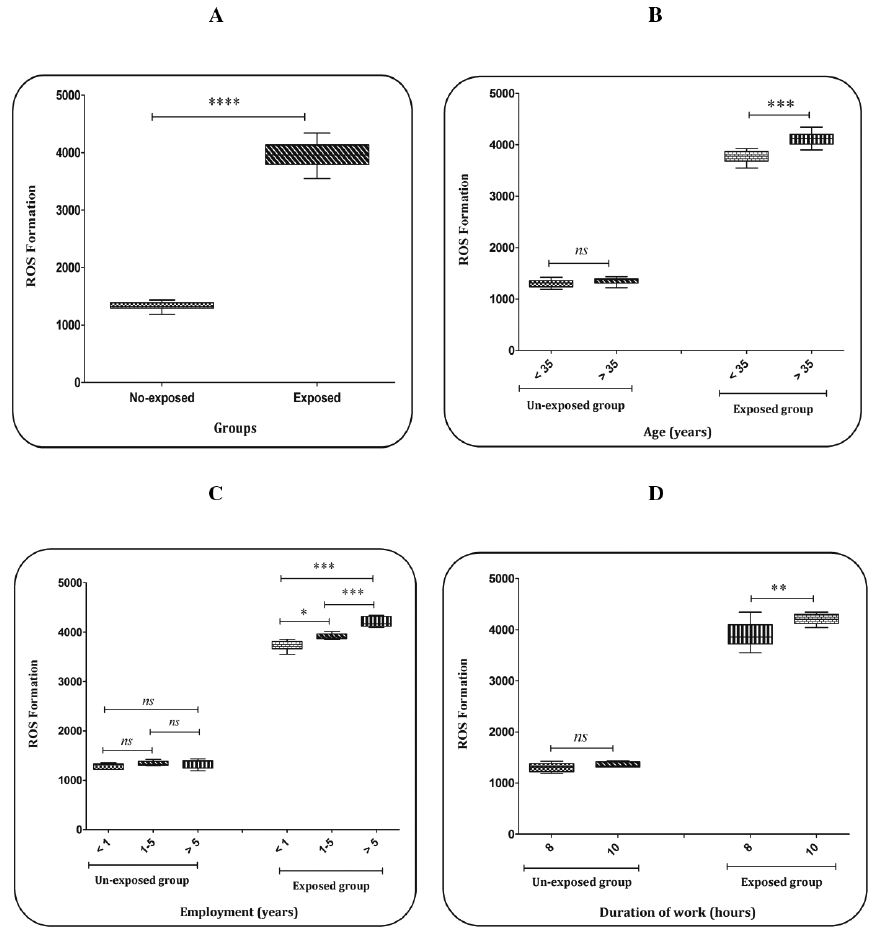
Figure 2: The mitochondrial ROS assay. (a) Comparison between exposure and non-exposure groups. (b) Comparison between the exposed and unexposed groups based on age (year). (c) Comparison between the exposed and unexposed groups based on employment (year). (d) Comparison between the exposed and unexposed groups based on duration of work (hours). Data are presented as mean ± SD (n = 20). * P < 0.05, ** P < 0.01, *** P < 0.001 and **** P < 0.0001. The unit of measurement of ROS formation is based on fluorescent